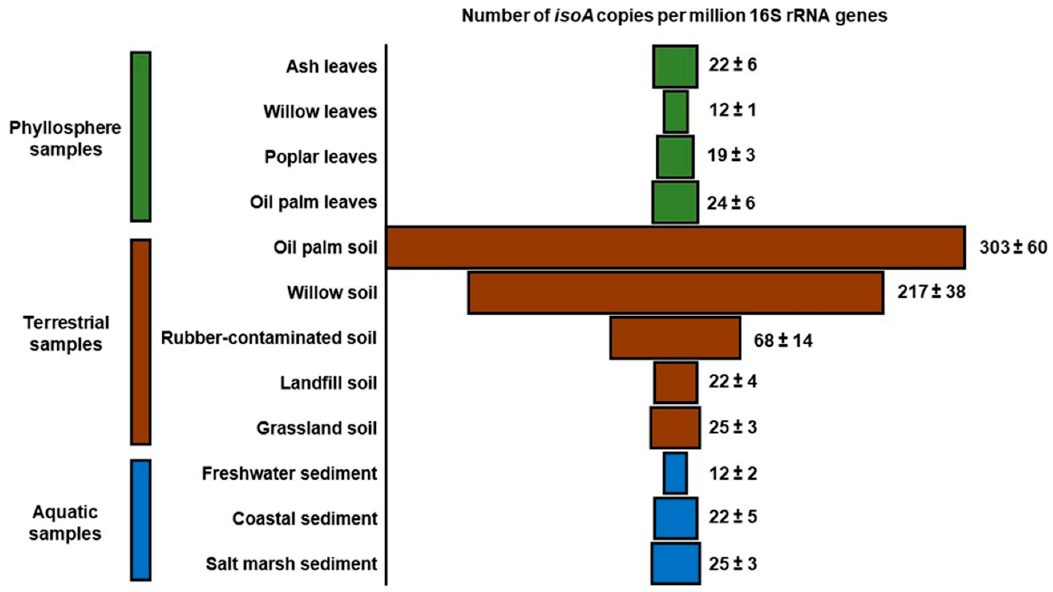
Figure 4. Relative abundance of isoprene degraders in natural (non-enriched) environmental samples determined by qPCR. Copies of isoA are normalised to the 16S rRNA gene copy number in each sample. Phyllosphere samples are coloured in green, soils in brown, and aquatic environments in blue. Data from [69].